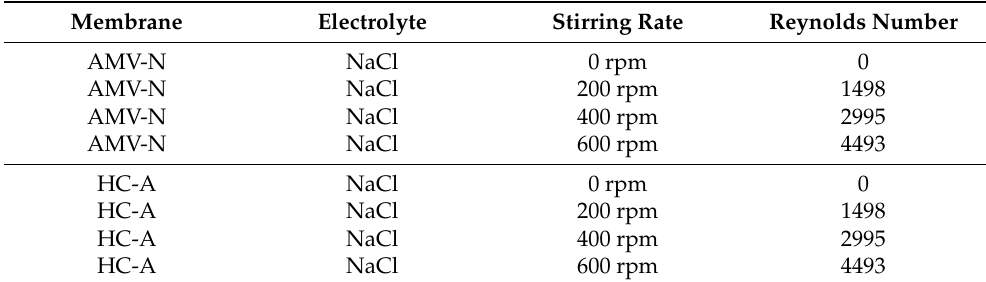
Table 1. Experimental conditions applied in the electrochemical characterization of the membrane- electrolyte systems.